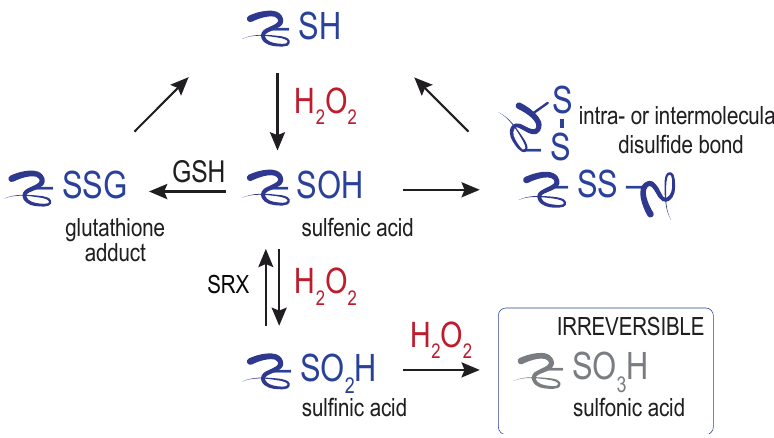
Figure 2. Cysteine modifications initiated by H 2 O 2 . Hydrogen peroxide (H 2 O 2 ) reacts with target protein cysteine thiol (–SH), producing a sulfenic acid adduct. Subsequent reactions with glutathione (GSH), protein thiols, or H 2 O 2 can generate additional modifications. Glutathione adducts, disulfides, and sulfinylated proteins can be reduced to the free thiol state through the action of proteins and low-molecular weight thiols [4]. The only established route for reduction of sulfinylated cysteines is by sulfiredoxin (SRX). Sulfonylated cysteines are considered irreversible oxidation products. This figure depicts the further modification of sulfenic acid by thiols (GSH, proteins) or H 2 O 2 . However, sulfenic acids can react also with a backbone amide (forming sulfenylamide), condense with another sulfenic acid (forming a thiosulfinate), or undergo further modification by hydrogen sulfide; these modifications are not shown here and are further discussed in [4,25,26].